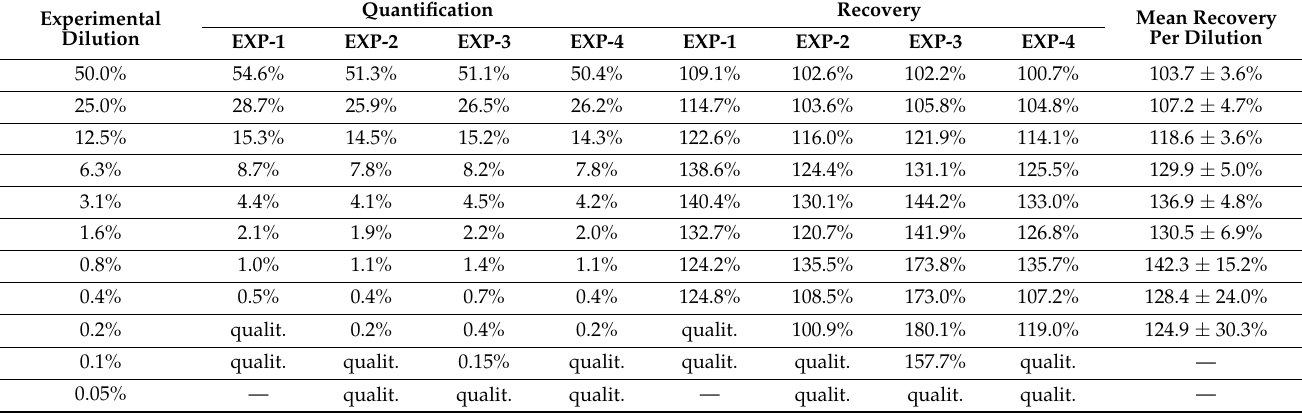
Experimental dilutions to 0.02% and 0.01% for all experimental runs and one sample of EXP-1 (0.05% dilution) were measured with a Ct above the defined detection limit of Ct ≥ 35 (or no Ct) and excluded from quantification (—). Qualit. means a valid qualitative signal which was below the lower limit of quantification (LLOQ) but above the lower limit of detection (LLOD) with a relatively high standard deviation (SD) amongst the replicates. In terms of specificity for the WPRE-specific PCR, we observed an unspecific signal in some negative-control samples (non-transduced cells) from Ct 35.8 and higher. Thus, we set the technical limit of detection to Ct 35 for the WPRE-targeting PCR and samples with a Ct ≥ 35 were excluded from analysis. All relevant quantification parameters were